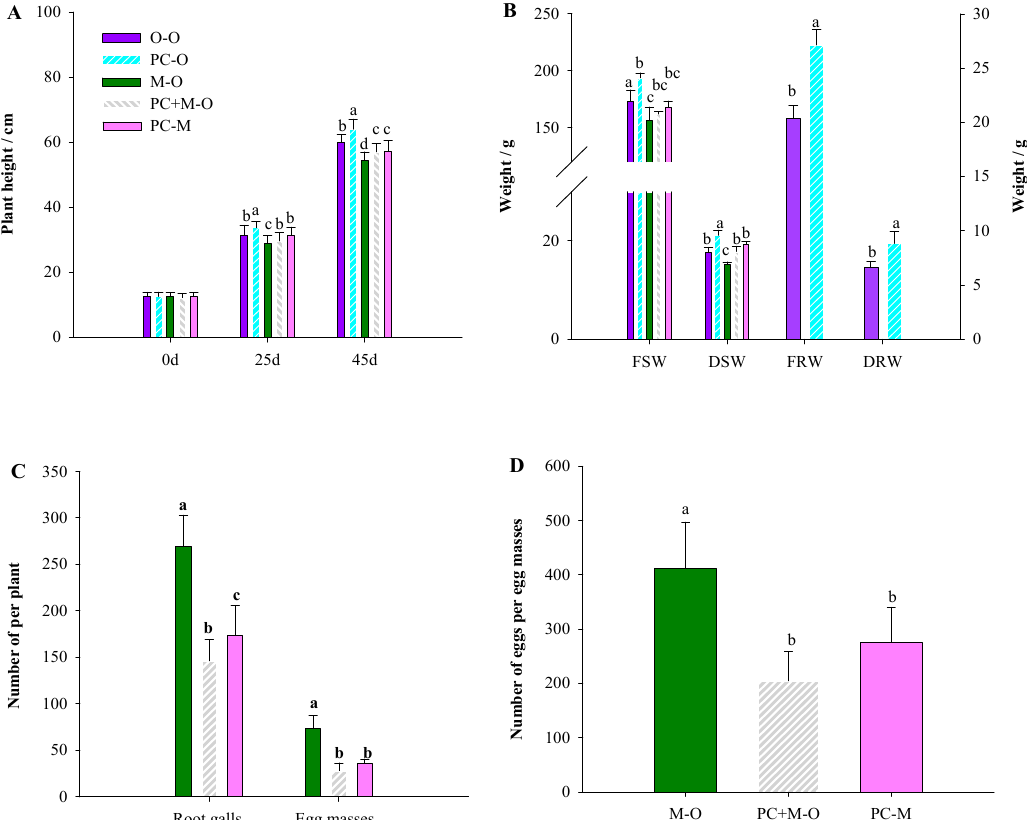
Figure 4. PC-170 improves tomatoes’ resistance to Meloidogyne incognita. O–O: The left and right root systems were not treated. PC–O: Just the left root system was pre-inoculated with PC-170. M–O: Just the left root system was challenged with M. incognita . PC+M–O: The left root system was pre-inoculated with PC-170 and challenged with M. incognita . PC–M: The left root system was pre-inoculated with PC-170 while the right was challenged with M. incognita . ( A ) Plant height at 0 d, 25 d, and 45 d under different treatments in split-root experiments. ( B ) Split-root experiments. FSW: fresh shoot weight; DSW: dry shoot weight; FRW: fresh root weight; DRW: dry root weight. ( C ) In the split-root experiment, the number of root galls and the number of egg masses. ( D ) In the split-root experiment, the number of eggs per egg mass. Each value is the mean ± SE ( n = 30). Different letters indicate statistical differences between treatments ( p < 0.05).